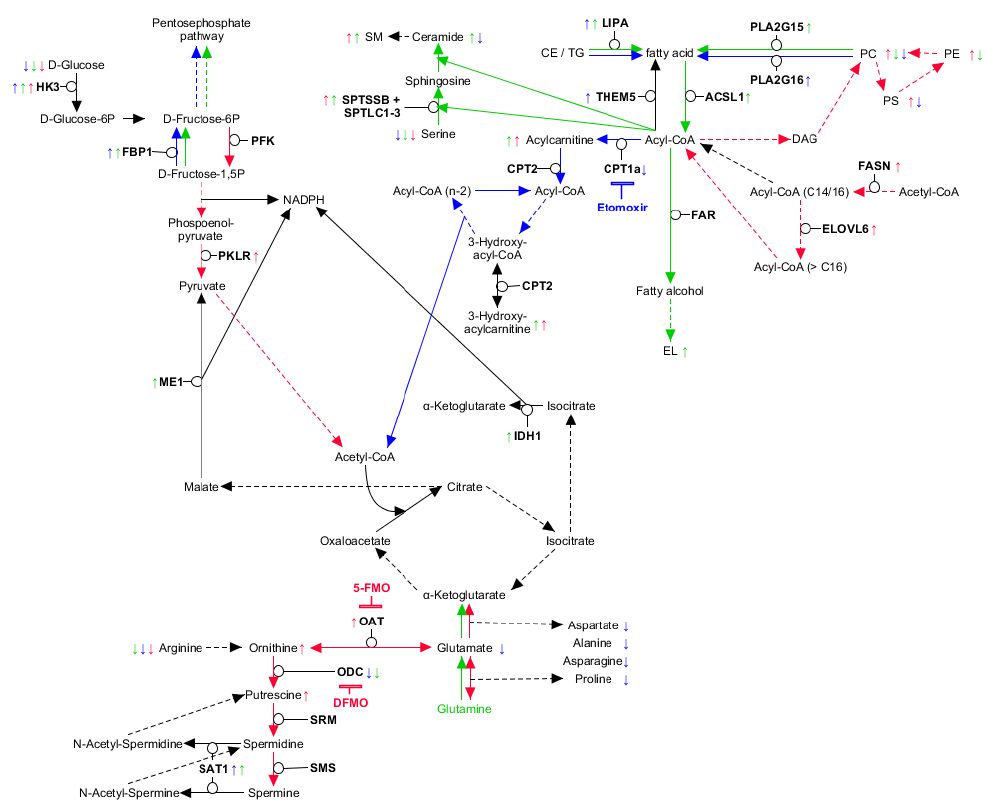
Figure 5. Involvement of unique metabolites in interconnected metabolic pathways. Model depicting the interconnection of key reactions of glycolysis, Krebs cycle, glutaminolysis, FAO and lipid metabolism. Di ff erences in concentrations and proposed activities found are highlighted for neutrophils (blue), dendritic cells (green) and erythrocytes (red). Furthermore, inhibitors (DFMO, 5-FMO, Etomoxir) are indicated in the respective color of the lineage, affected by the corresponding inhibitor. The model was generated using KEGG pathways as the template [77].